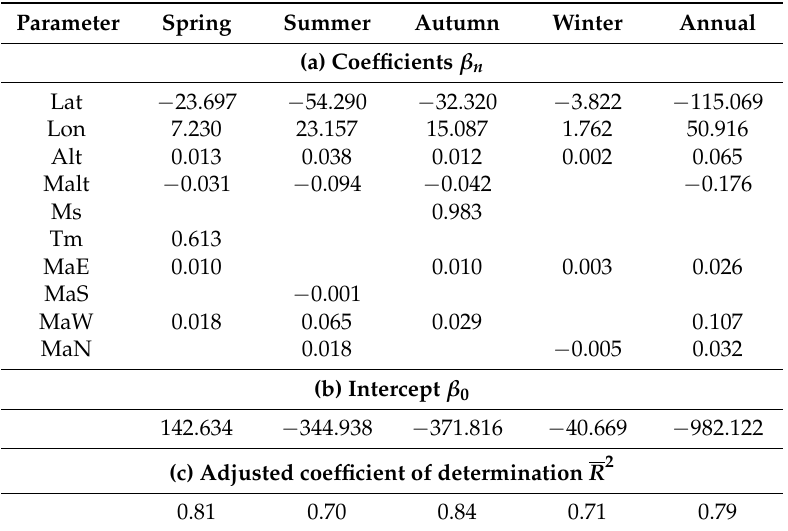
Table 5. Correlation coefficients between precipitation from different time scales and influence factors of the multivariate regression